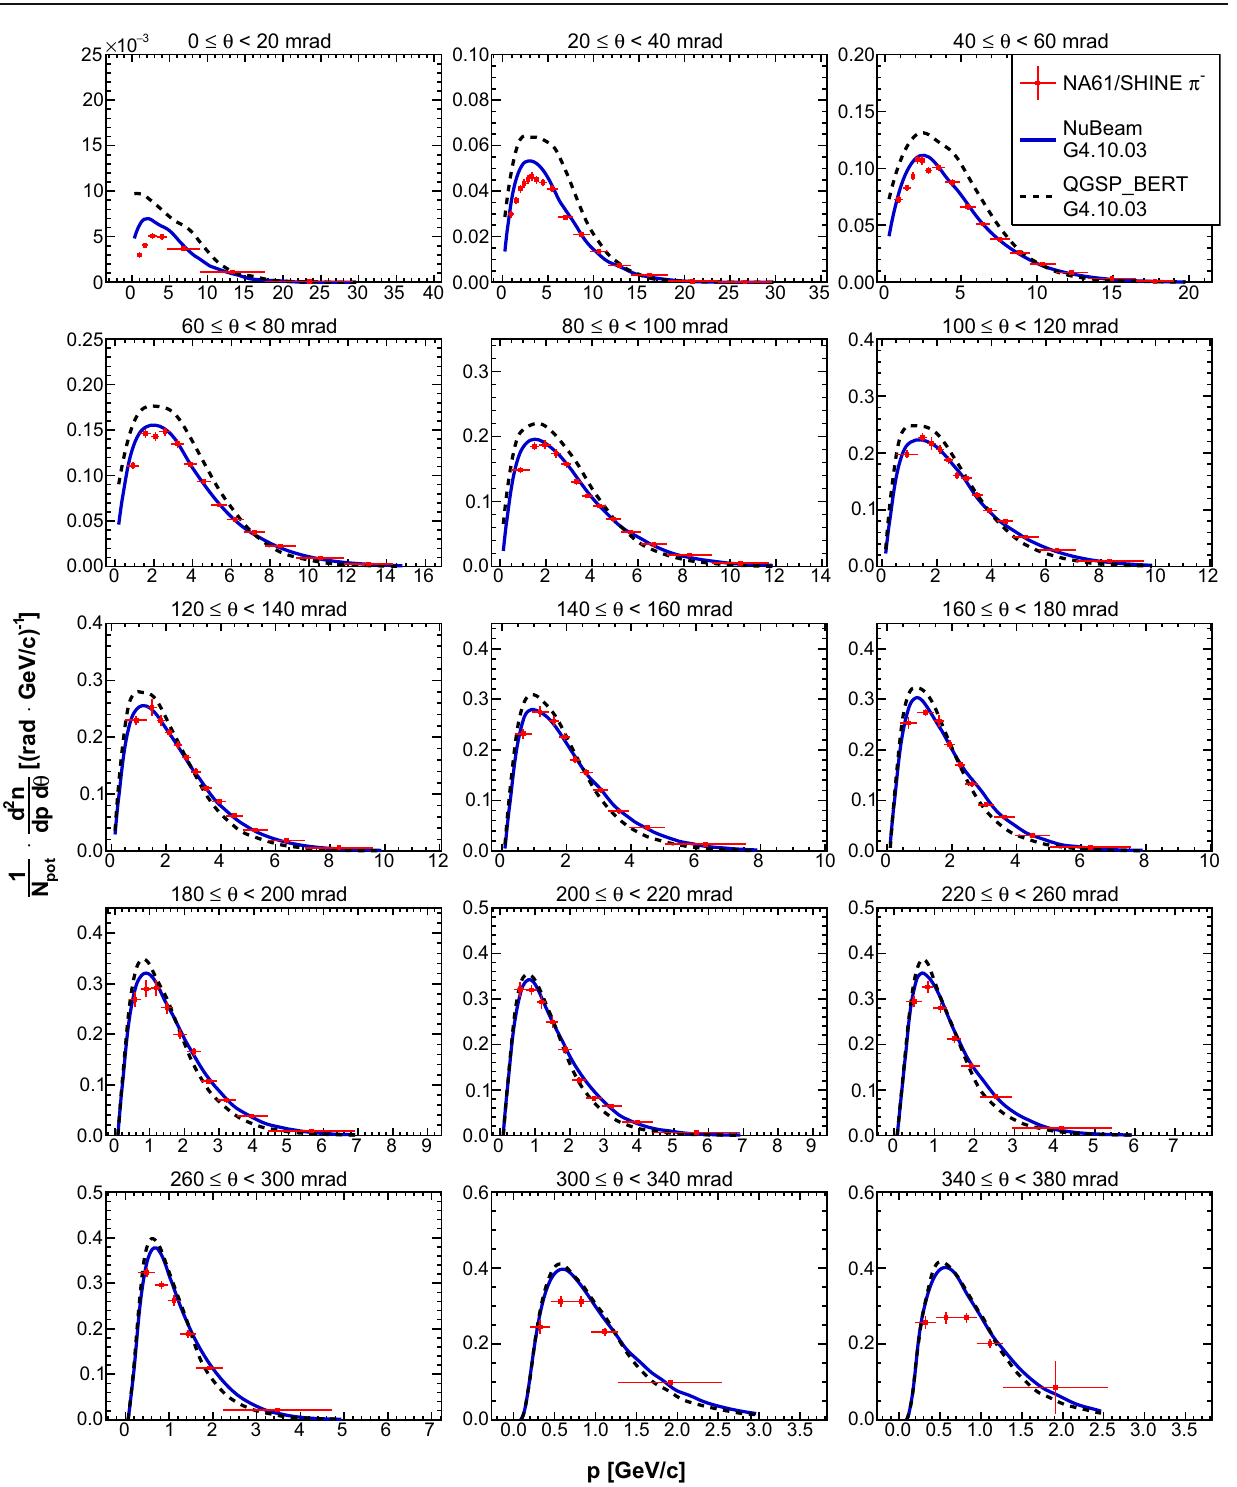
Fig. 32 Double differential yields of negatively charged pions for the fourth upstream longitudinal bin (54 ≤ z < 72 cm). Vertical bars represent the total uncertanties. Predictions from the NuBeam (solid